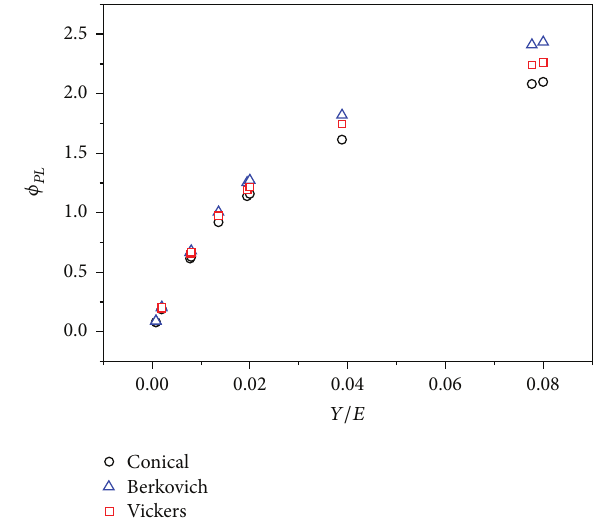
Figure 5: The variation of dimensionless function 𝜙 𝑃𝐿 = 𝑃/(𝐸ℎ 2 ) with respect to 𝑌/𝐸 for different kinds of